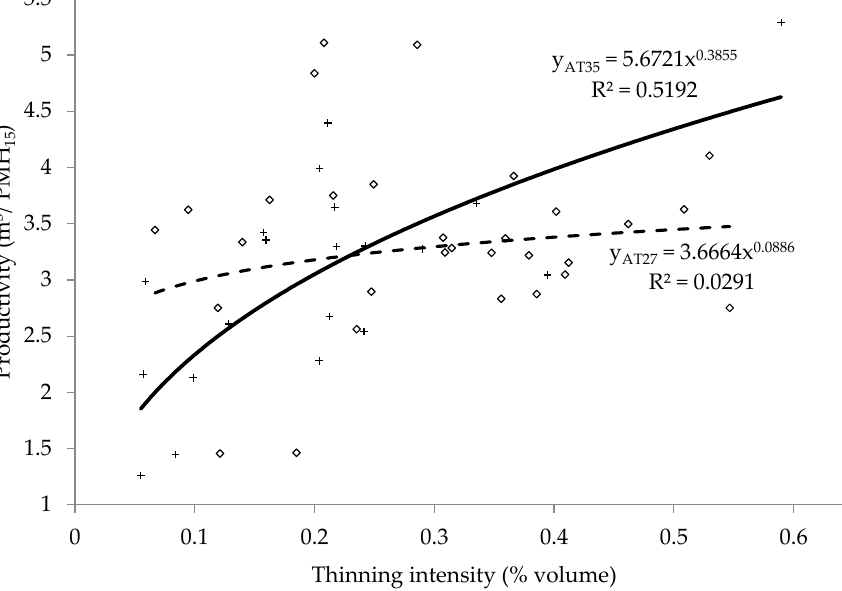
Figure 3. Marginal productivity functions for Model 3 and Model 4 (Table 8; Equation (3)).